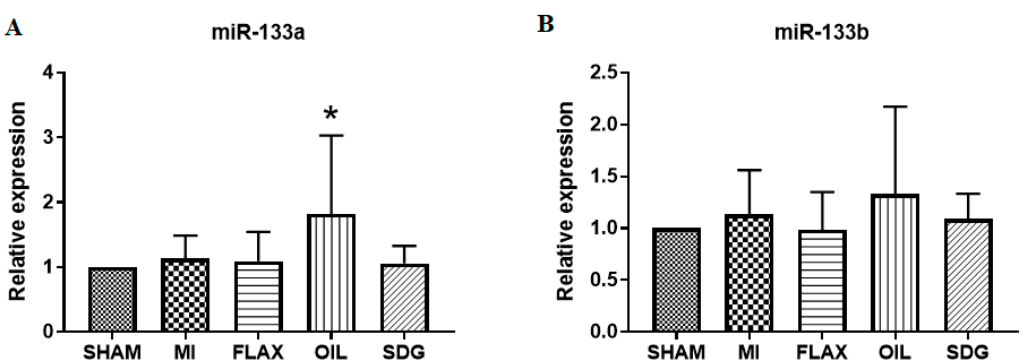
Figure 3. Effect of dietary interventions on miR-133 expression levels. ( A ) miR-133a; ( B ) miR-133b. Data are presented as mean ± SD, n = 5–6. * Significantly different from sham, p < 0.05. ALA, alpha-linolenic acid; FLAX, chow diet supplemented with 10% ground flaxseed; MI, myocardial infarction; OIL, chow diet supplemented with 4.4% ALA enriched flax oil; SDG, chow diet supplemented with 0.44% secoisolariciresinol diglucoside.